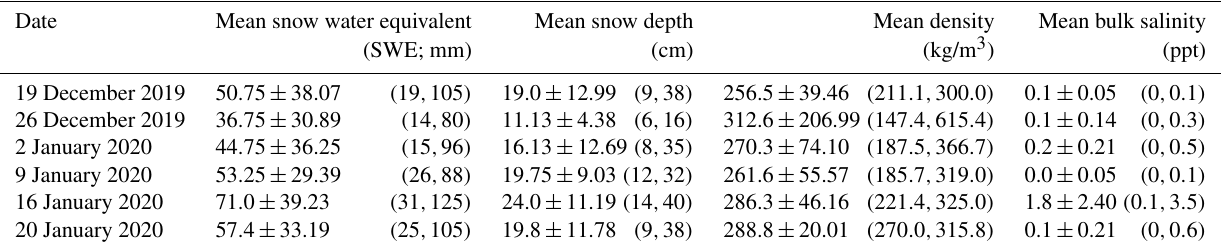
Table 2. Summary of snow pit properties along northern transect. Values are given as averages, standard deviations, and min and max (in parentheses) from two to six snow pits. Results show considerable variability in snow water equivalent (SWE) and snow depth.